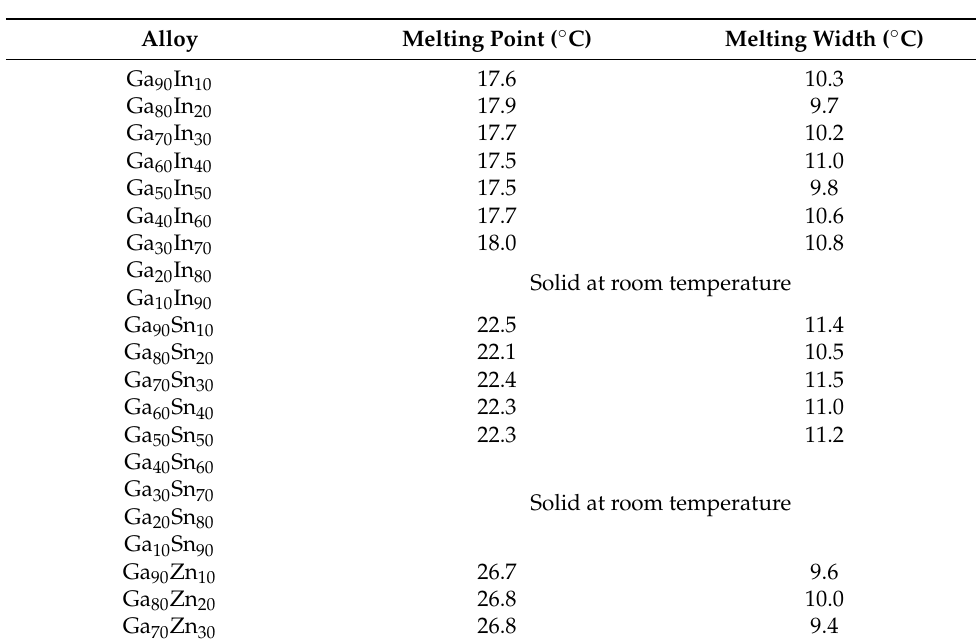
Table 2. Gallium-based alloy melting point with different elements (each value in the metal column